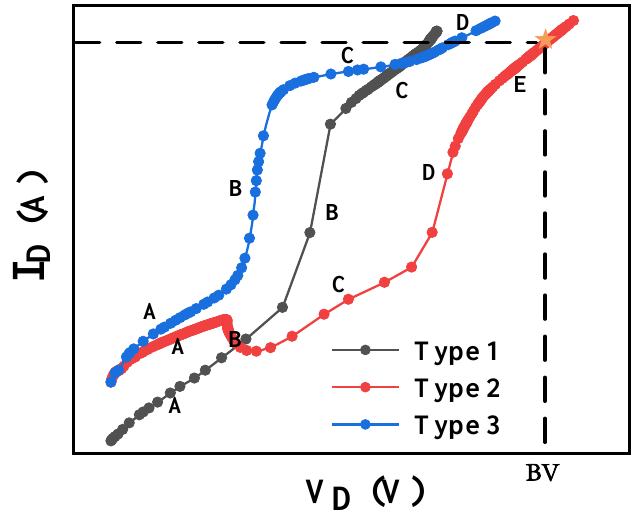
Figure 2. The off-state I – V curve of AlGaN/GaN HEMT. For the ANN architecture used in this paper, the input neurons represent the applied voltage (i.e., V gs , V ds ) and structure parameter (i.e., t 1 , t 2 , t bar et al.). Figure 3 shows the overall flow of the proposed framework for off-state performance characterization. The number of hidden layers and the neurons are the training hyperparameters (i.e., weight, bias), which are subject to the tuning process to realize the optimal solution according to the complexity of the prediction task. The neurons of the output layer represent the current-related features, which are used as the input of the conversion function. As for the configurations for the proposed ANN, first, ReLU is employed as the nonlinear activation function [14]. Then, Adam optimizer is used to perform the error backpropagation process by updating the training parameters [15]. In addition, an adaptive learning rate is utilized to control the optimization process [16]. Moreover, the error between the output layer and the targets can be evaluated as the mean square error ( MSE ) [17], which can be formulated as: